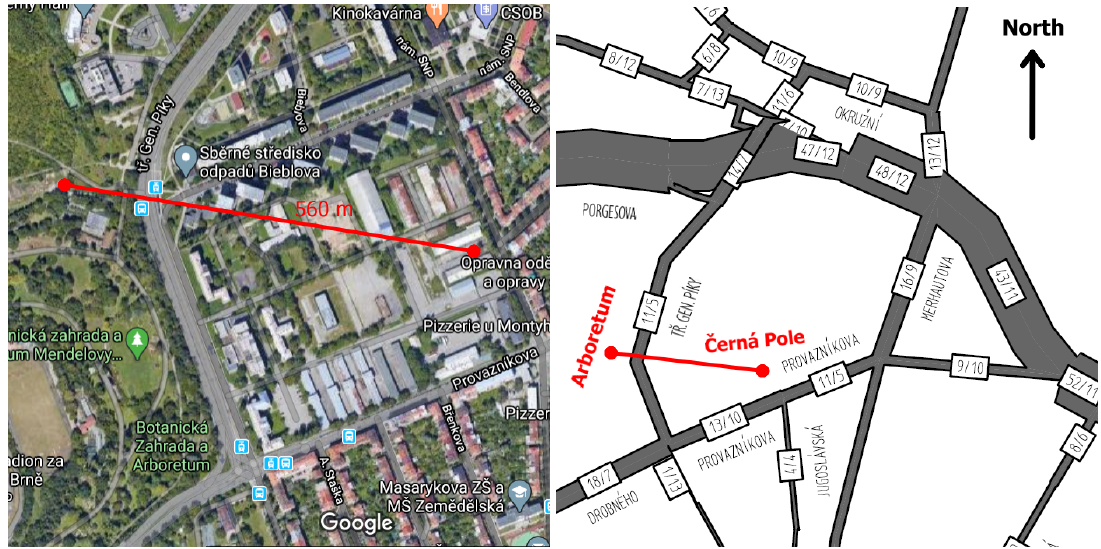
Figure 1. A map with the stations (left) and a traffic intensity map in the vicinity of the stations (right).